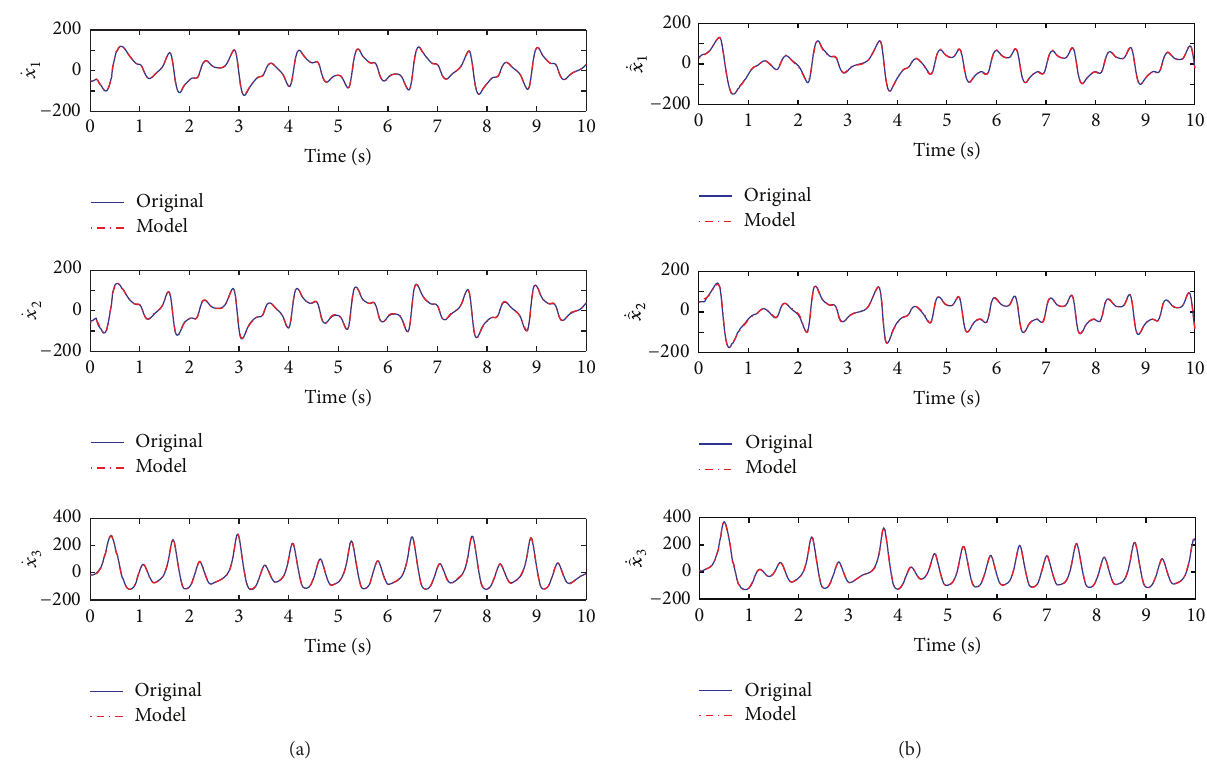
̇̂𝑋(𝑡) for original system and NN model.